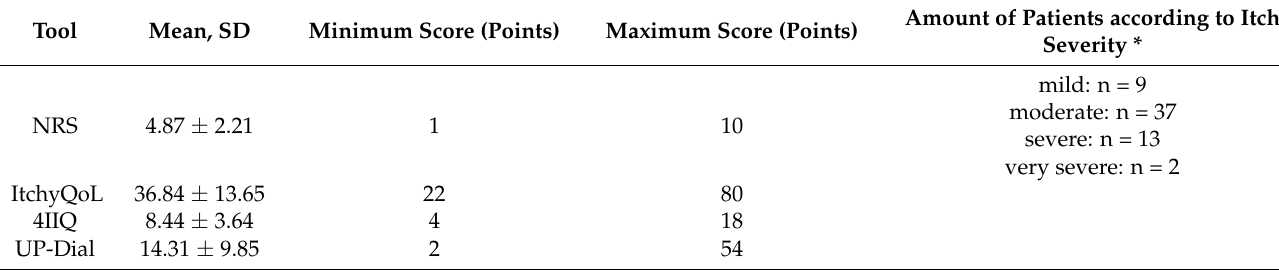
Table 2. Pruritus Assessment in hemodialysis